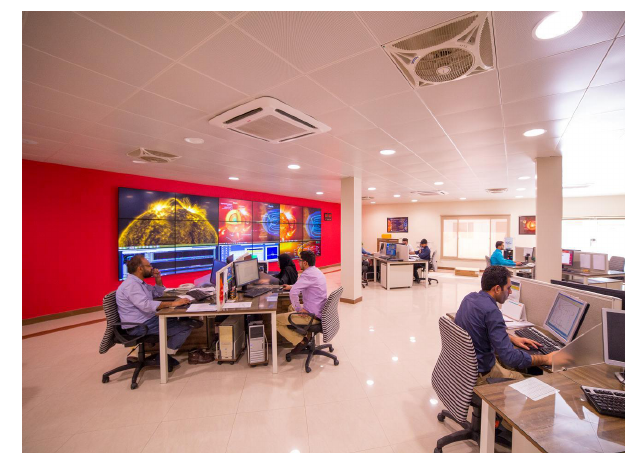
Figure 16. An image from the Pakistan Space Weather